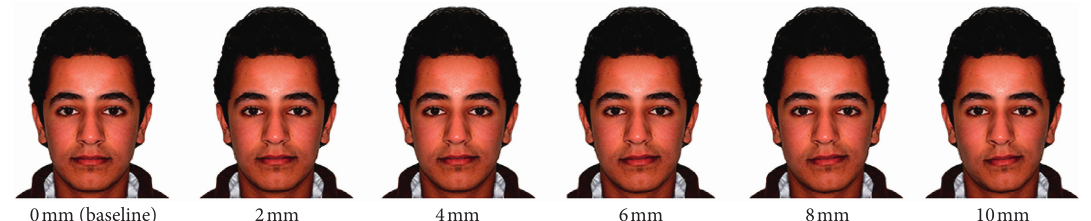
Figure 1: Baseline and manipulated images to affect the symmetry of the